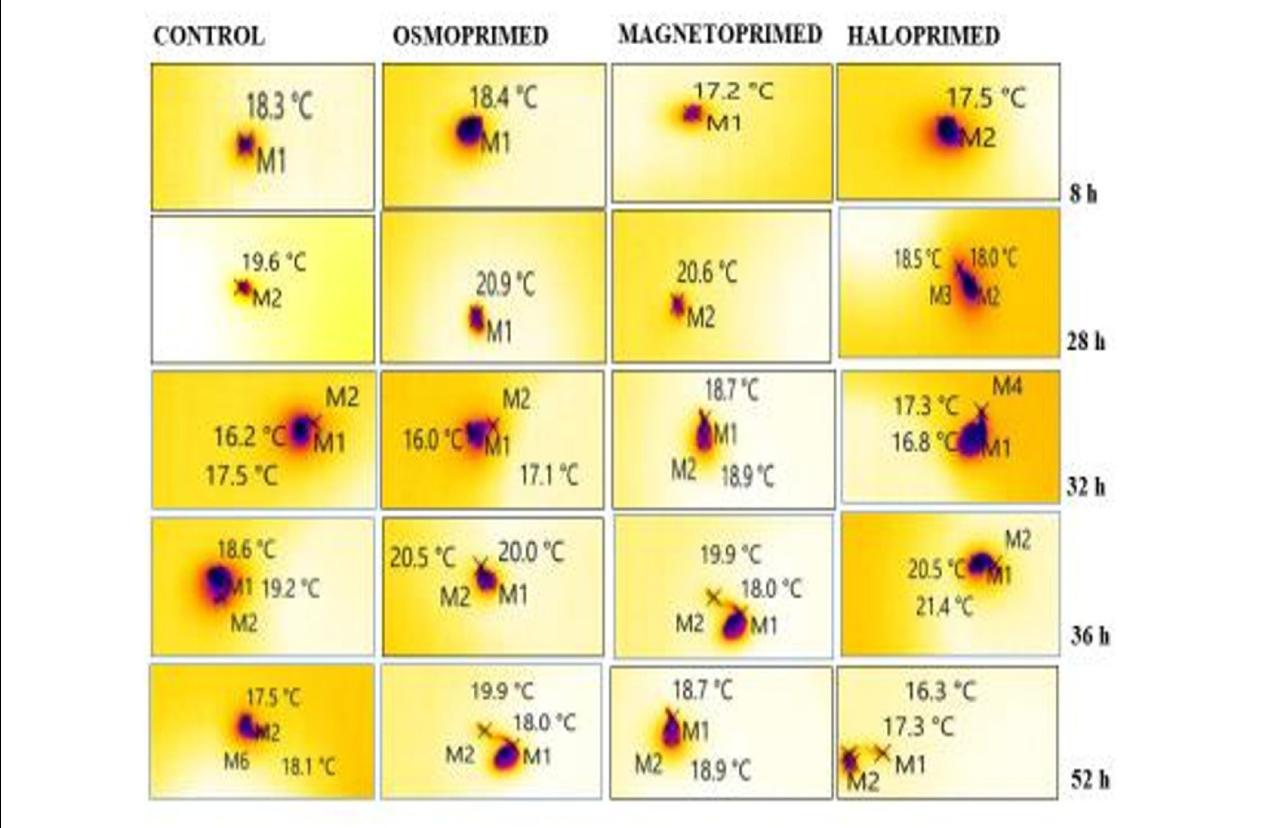
FIGURE 3 | Representative thermal images of differently primed onion seeds at different imbibition time. “M” marks on the images represent the point selected for determining the temperature of the imbibed